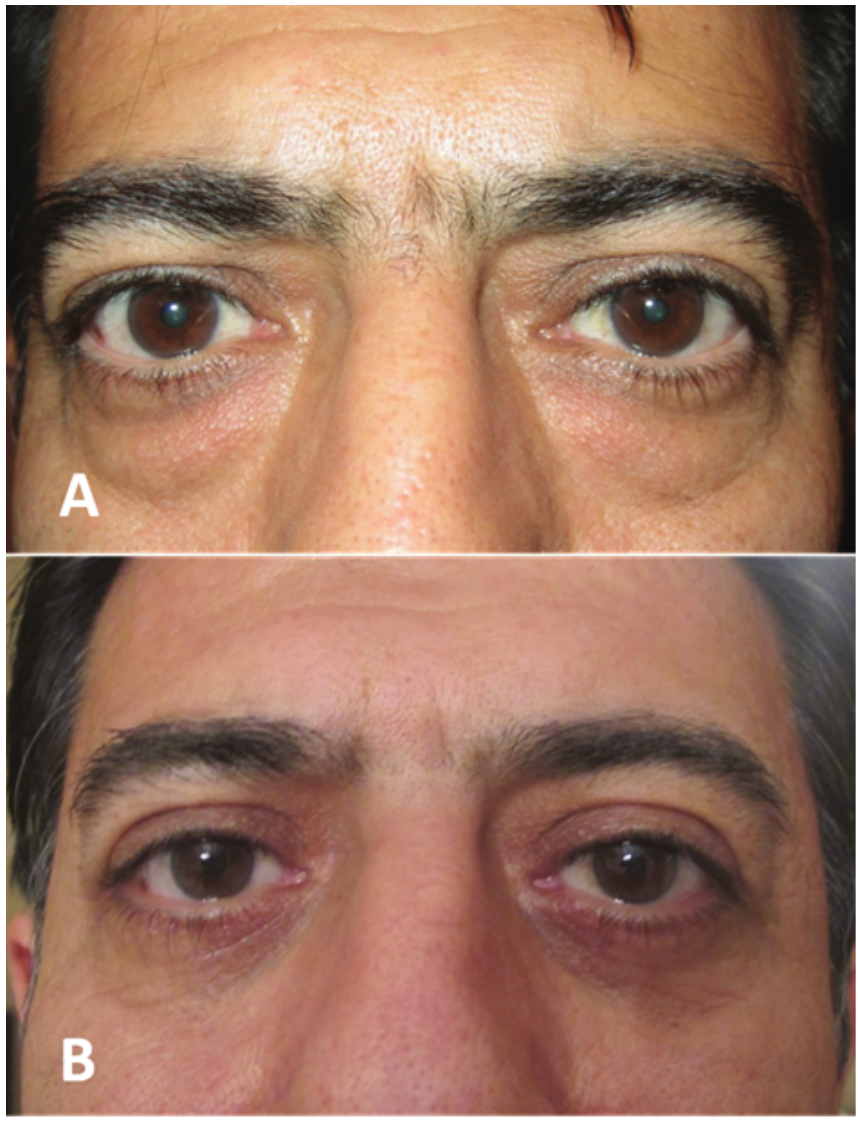
Figure 4. A patient before (A) and after (B) upper and lower blepharoplasty with trans-blepharoplasty corrugator excision. Trans- blepharoplasty glabellar myoplasty (corrugator muscle deactivation) leads to medial eyebrow